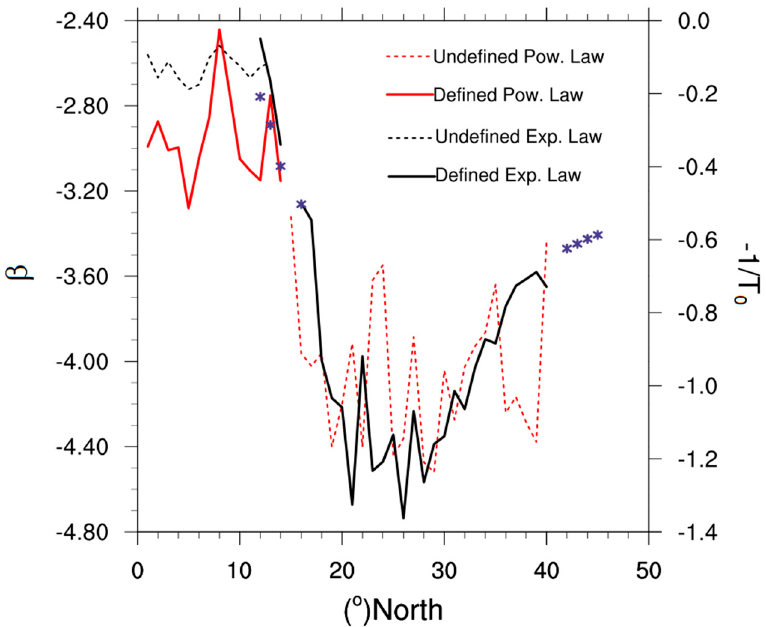
Figure 5. Exponent β (red) and inverse of the characteristic duration − 1/ T 0 (black, in day − 1 ) as function of the latitude between 0 and 40° N in the area where exponential and power laws are defined (solid lines) or not (dashed lines). Blue stars represent the − 1/ T 0 (in day − 1 ) slope in the four sites of Senegal and France measured from rain gauge data, corrected with Equation (2).